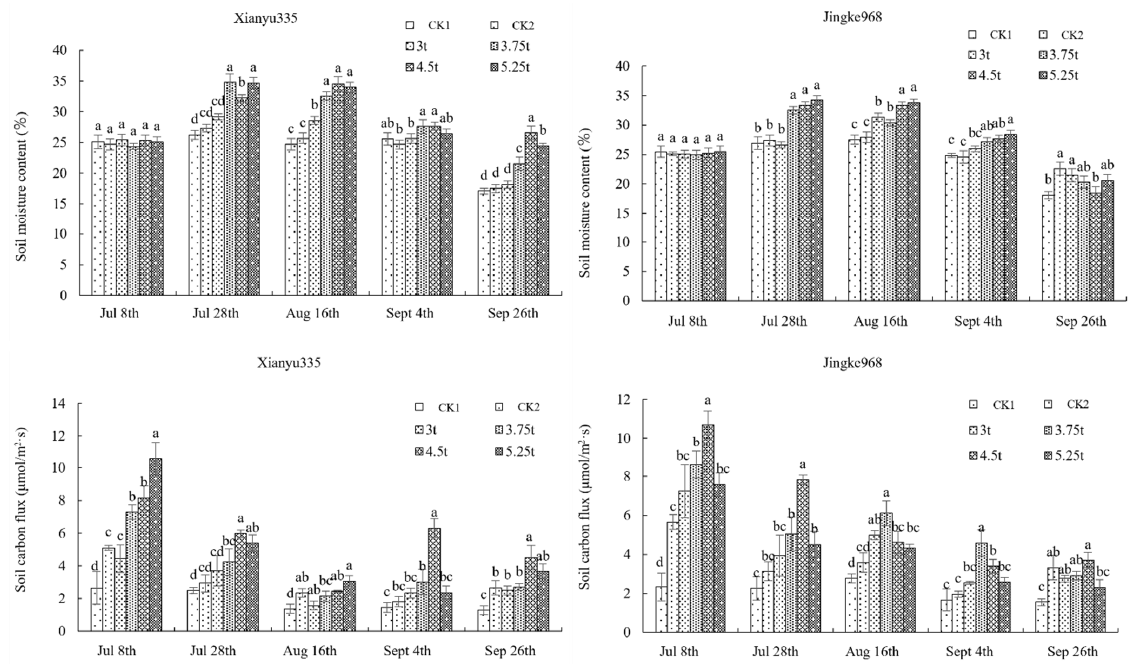
Figure 2. Effect of carbon-based fertilizer on soil moisture content and soil carbon flux. Notes: